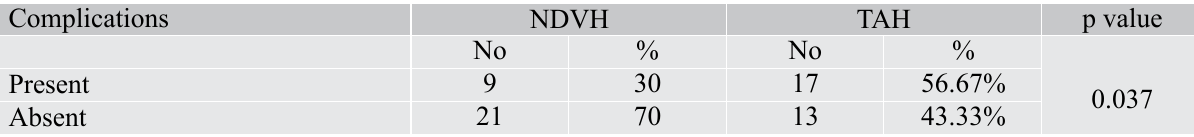
Table VII: Comparison of hospital stay between NDVH and TAH groups Hospital stay <7